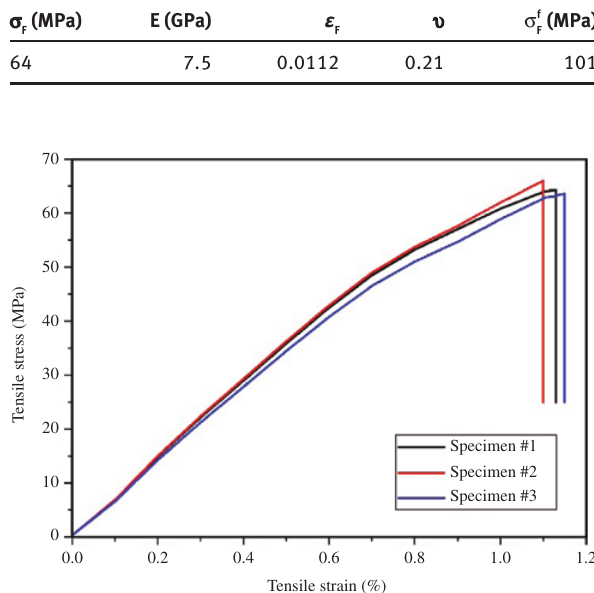
Figure 5: The tensile stress-strain curves of face sheet.